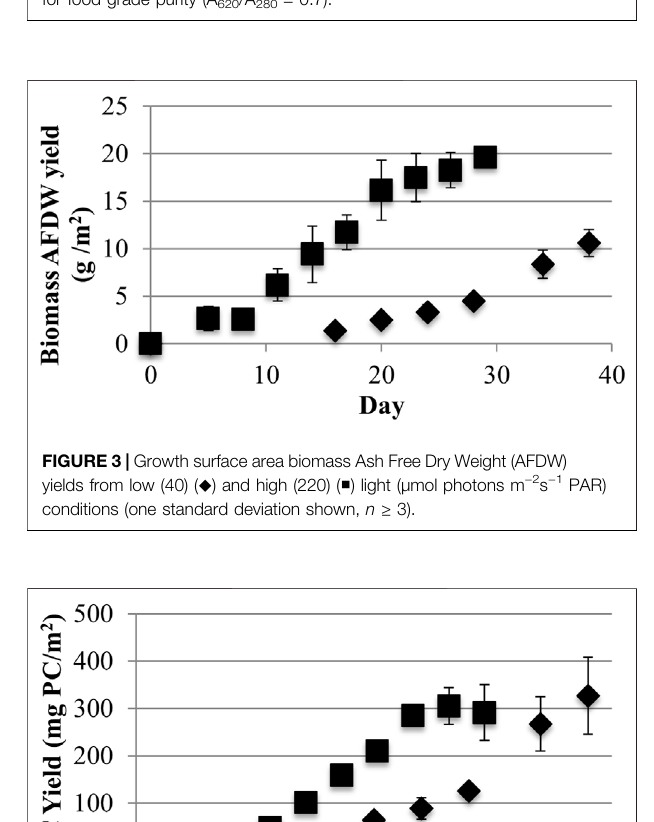
FIGURE 2 | Phycocyanin (PC) purity (A620/A280) from low (40) ( ◆ ) and high (220) ( ■ ) light ( μ mol photons m − 2 s − 1 PAR) incidence (one standard deviation shown, n ≥ 3). The shaded horizontal bar shows the minimum limit for food grade purity (A 620 /A 280 = 0.7).